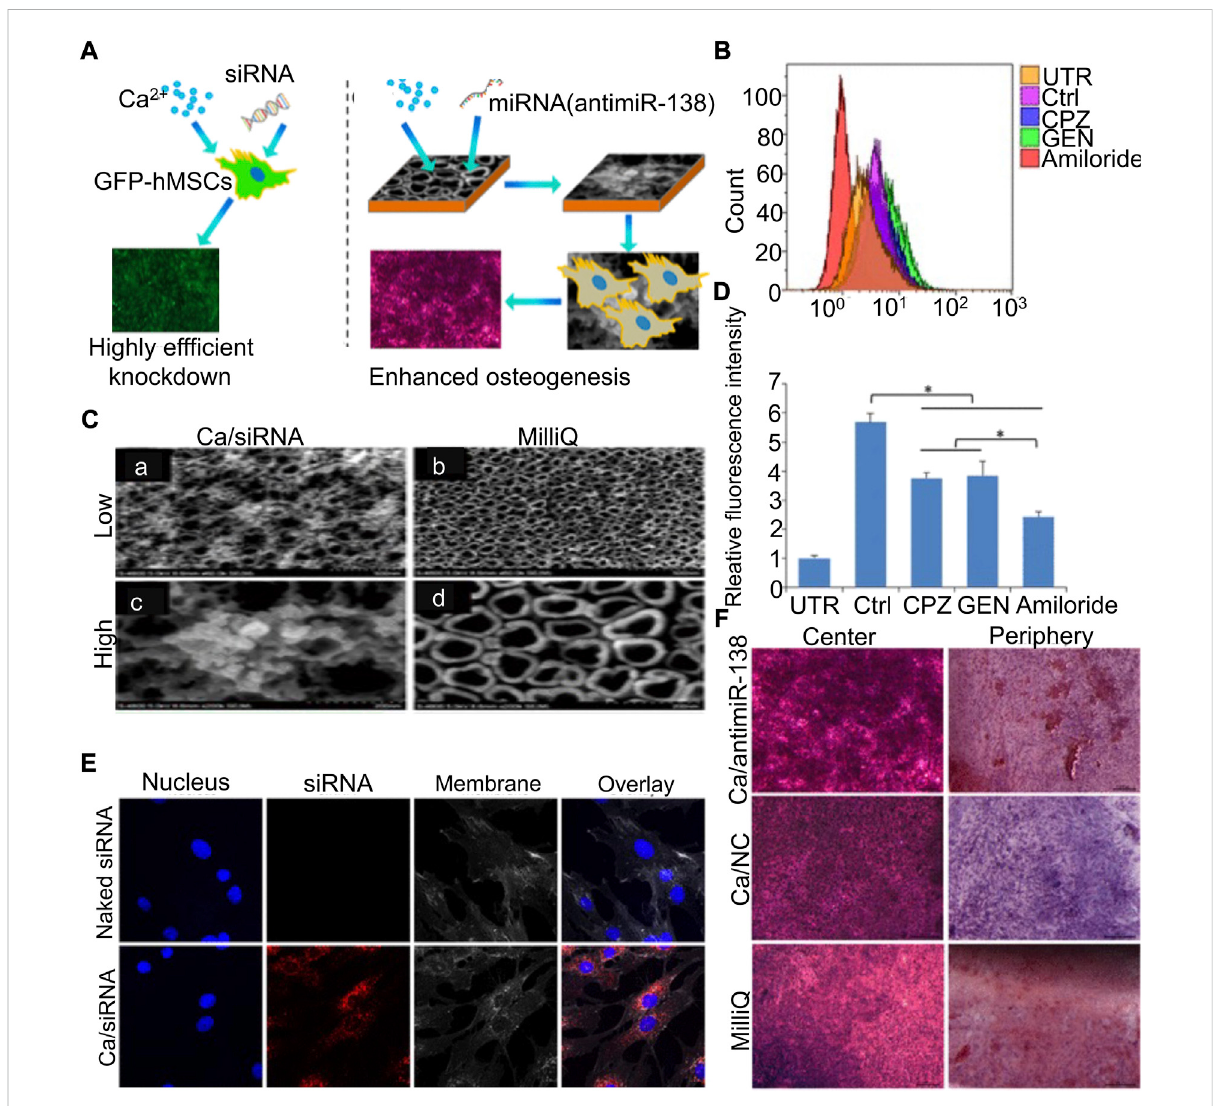
FIGURE 5 Calcium – microRNA complex combined with Ti scaffolds promoted osteogenic differentiation of hMSCs (Song et al., 2018). (A) Schematic diagram of the Ca/siRNA complex promoting osteogenic differentiation of BMSCs. Flow cytometry was used to analyze cell uptake (B) and quanti fi cation (D) after treatment with various cell phagocytosis inhibitors. (C) SEM observation of the TiO 2 surface immersed in Ca/siRNA (A,C) or Milli-Qwater (B,D) . (E) CellsweretreatedwithnakedsiRNAandCa/siRNA,respectively,andexaminedbyCLSM. (F) hMSCsco-culturedwithCa/ antimiR-138, Ca, and Milli-Q for 14 days, respectively, and stained with ARS. (UTR, untransfected cells; Ctrl, transfection without inhibitors; CPZ, chlorpromazine; GEN, genistein.) Copyright © 2018 American Chemical